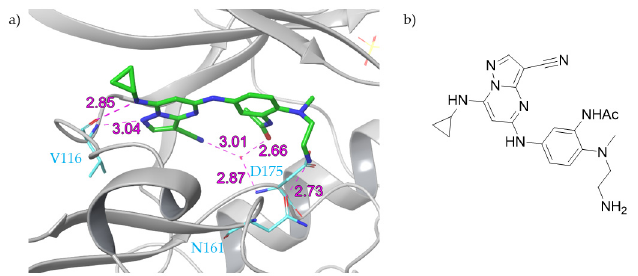
Figure 6. Depictions of the binding mode of AZ-7h in the ATP-site of CK2 α and the chemical structure of AZ-7h. ( a ) Crystal structure of AZ-7h bound in the ATP active site of CK2 α (PDB: 5H8E). Residues which form hydrogen bonds to the inhibitor are shown in cyan and the lengths of the hydrogen bonds given in Å. ( b ) Chemical structure of the pyrazolo-pyrimidine CK2 inhibitor